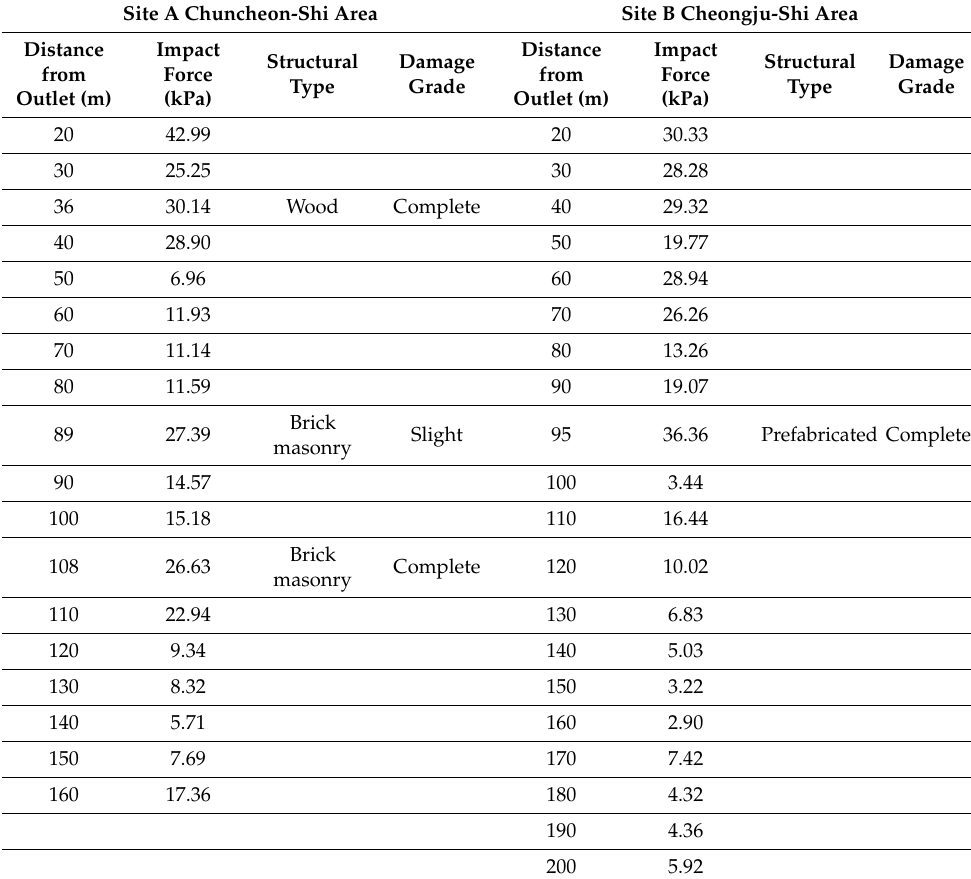
Table 2. Calculation of impact force from the outlet and the description of the damaged